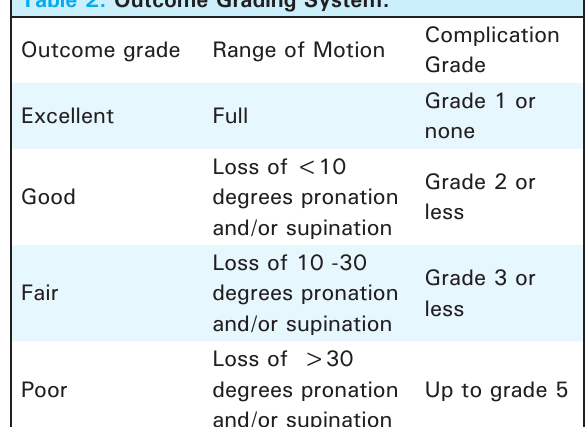
table 2. Outcome Grading